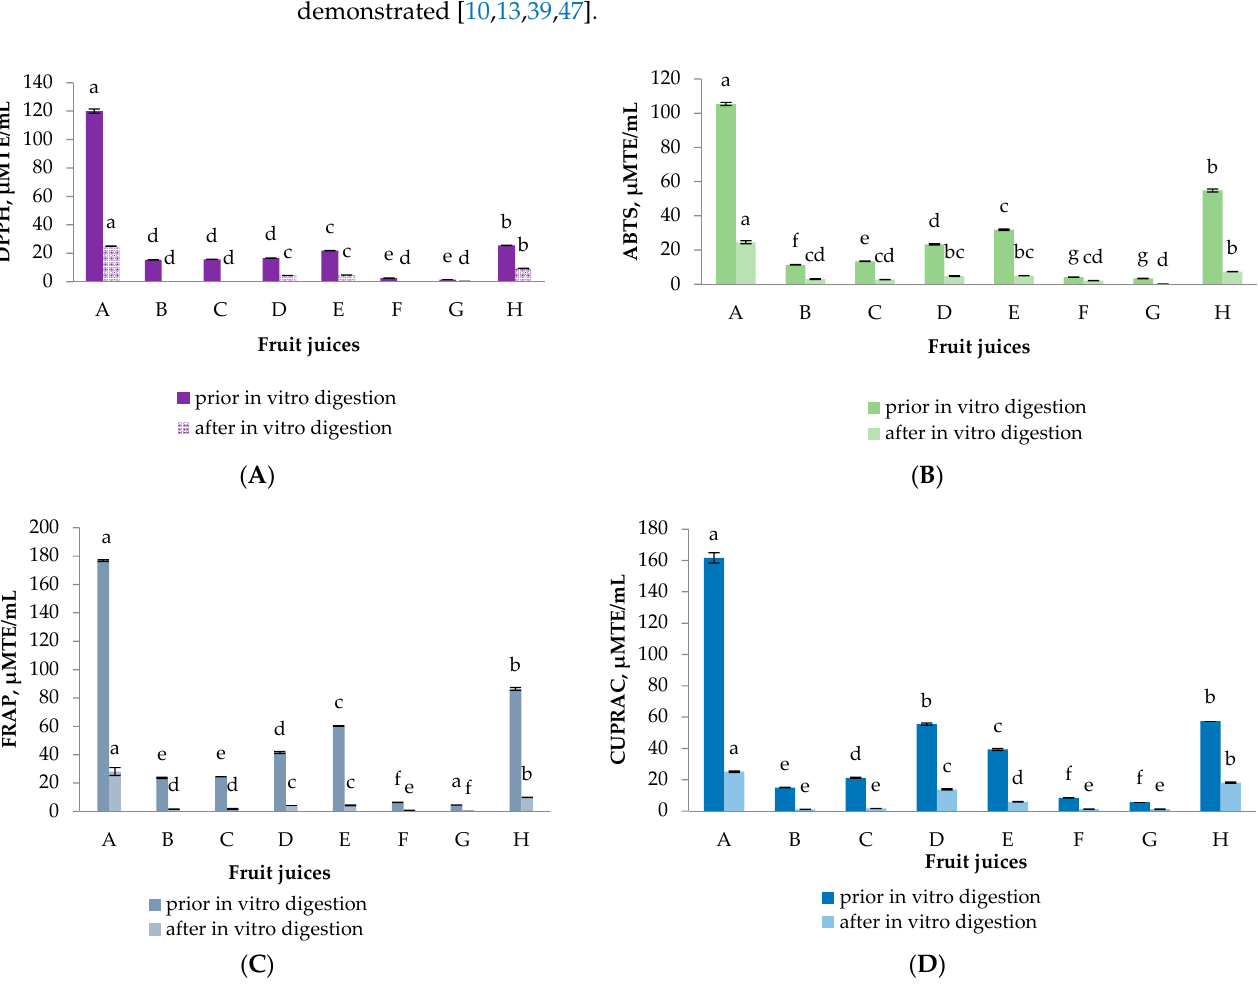
Figure 2. Antioxidant capacity of selected fruit juices before and after in vitro gastrointestinal digestion by ( A ) 2,2-diphenyl-1-picrylhydrazyl (DPPH) radical scavenging activity, ( B ) 2,2 ′ -azino-bis(3-ethylbenzothiazoline-6-sulfonic acid (ABTS) radical scavenging activity, ( C ) Ferric-Reducing Antioxidant Power (FRAP) and ( D ) Cupric Ion Reducing Antioxidant Capacity (CUPRAC) assays. The data is presented as the mean ( n = 3) ± S.D. Different letters within chart columns indicate significant differences between treatments according to Tukey’s test at p < 0.05.